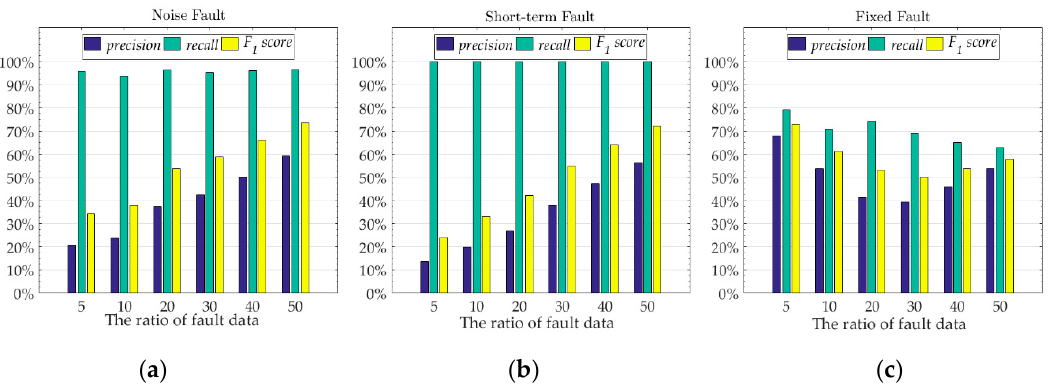
Figure 9. The fault detection performance of the model under different fault data ratios for three different fault. ( a ) noise fault, ( b ) short-term fault, ( c ) fixed fault. The value of the x -axis is the ratio of the number of fault data we add to the original sample to the total number of original sample data.